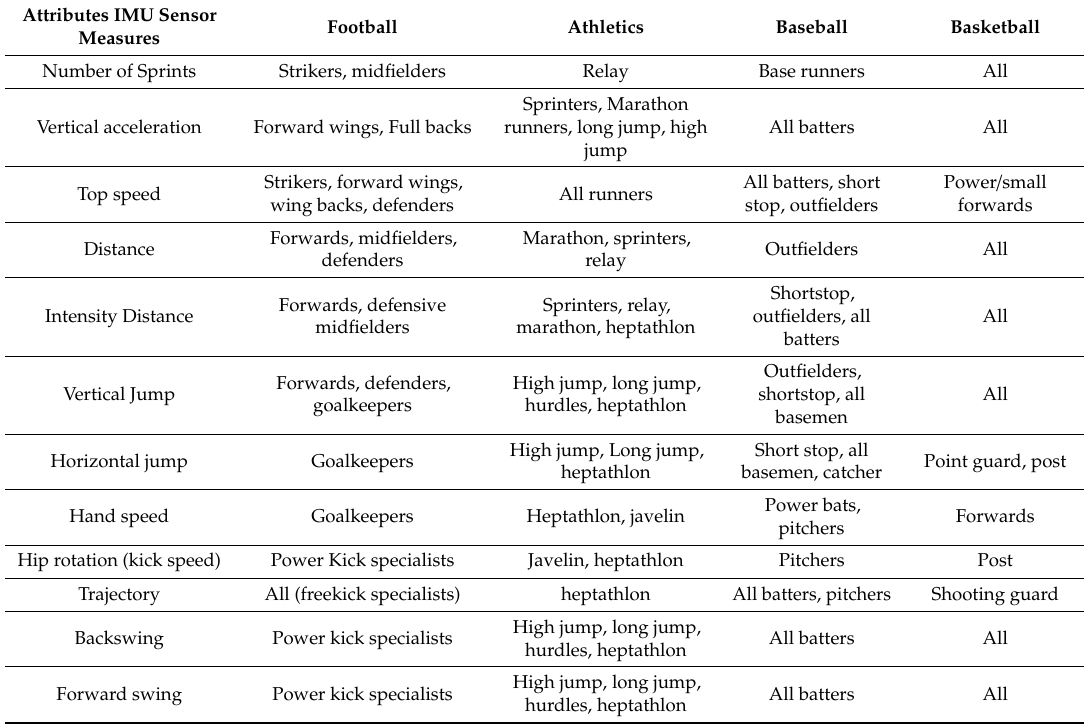
Table 7. Example of attributes that inertial measuring unit (IMU) sensors can track for specific positions in di ff erent